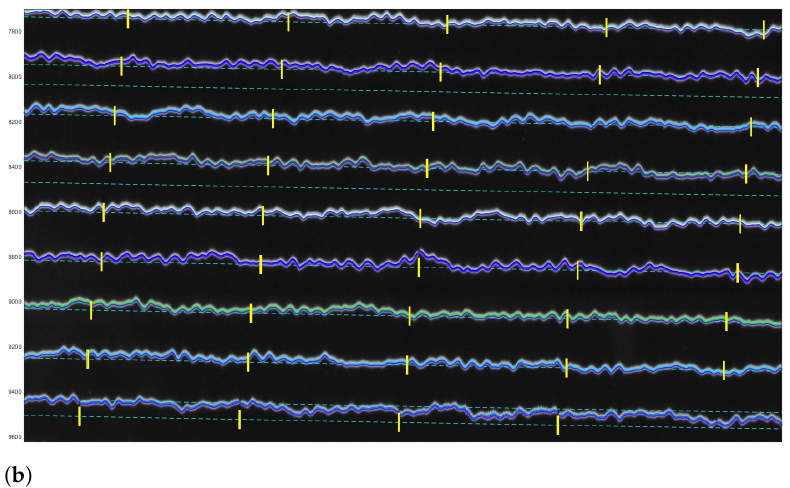
Figure 16. Corrected digitised traces upon completion of the semi-automated vectorisation. ( a ) Corrected digitised traces upon the completion of the semi-automated vectorisation process. ( b ) Visible SDT lines (bold) after the semi-automated vectorisation.